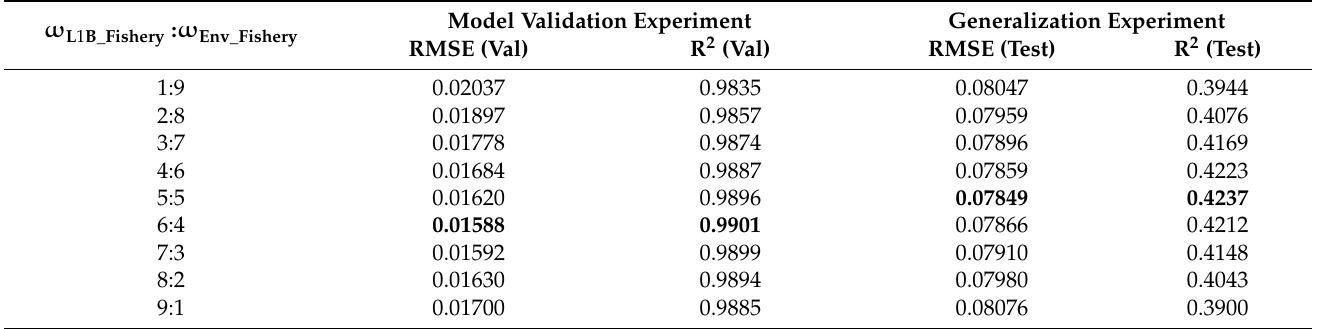
Table 4. The average performance of the nine-times decision fusion results of same kind of experi- ments with different weight ratios. Model Validation Experiment Generalization